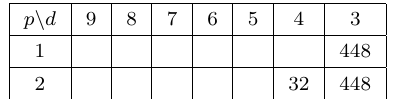
Table 30 . Number of E (5;6) -branes in the p -brane multiplet in d -dimensions [17]. p \ d